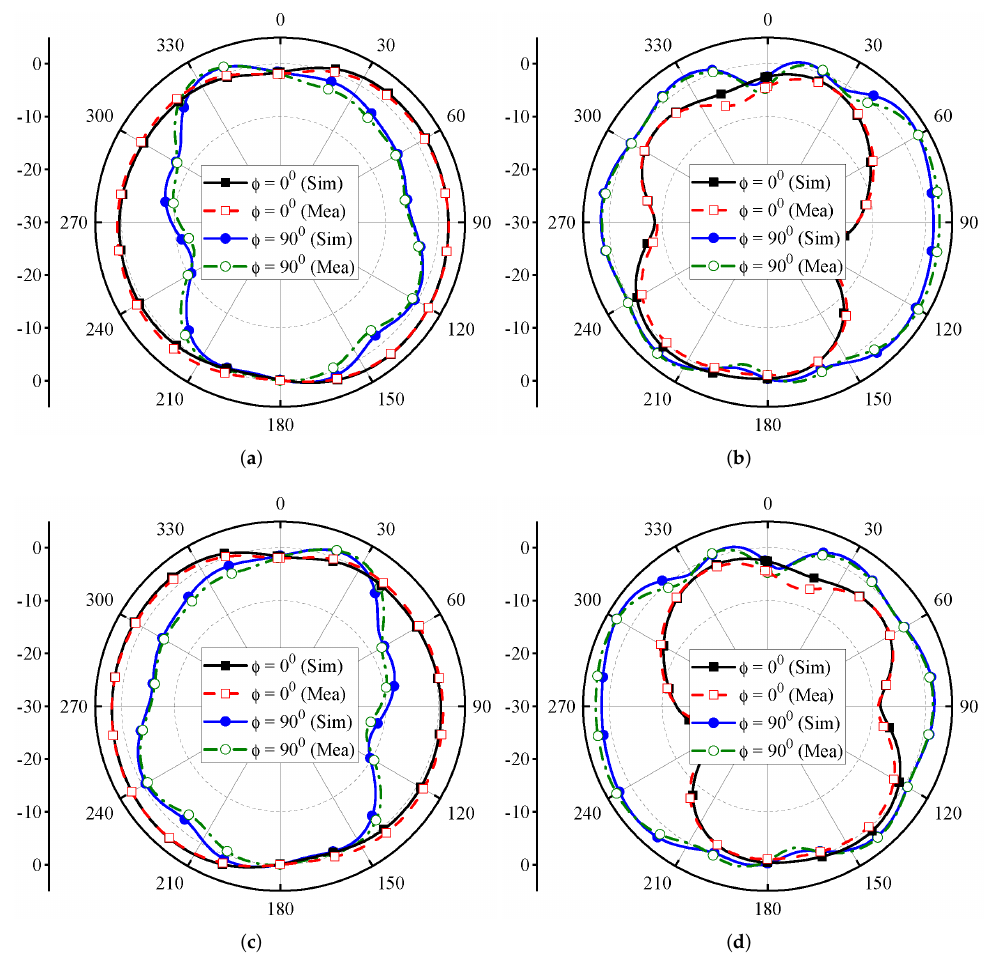
Figure 7. Far-field radiation characteristics of the proposed MIMO antenna at 24.5 GHz for ( a ) antenna- 1, ( b ) antenna-2, ( c ) antenna-3, and ( d )